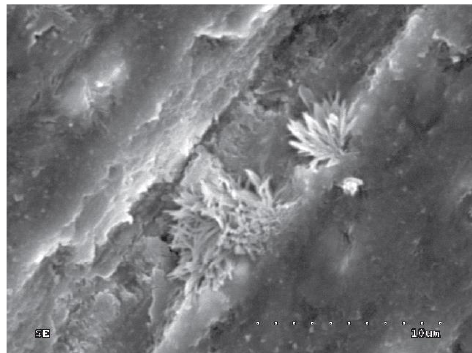
Figure 4. SEM image of dentine surface after application of 0.2% CHG for 30 s and rinsing with water–group 5, 5000×.